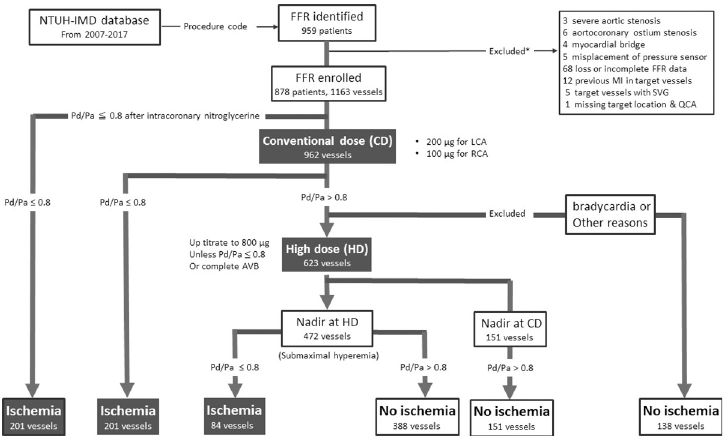
Fig 1. Diagram of patient flow. In the 1163 vessels, one-hundred thirty-eight vessels with negative FFR at conventional dose did not proceed to high dose intracoronary adenosine. � Severe aortic stenosis counts as per patient, otherwise count as per vessel. Abbreviations: FFR: fractional flow reserve; LCA: left coronary artery; NTUH-IMD: National Taiwan University Hospital integrated medical database; RCA: right coronary artery; SVG: saphenous vein